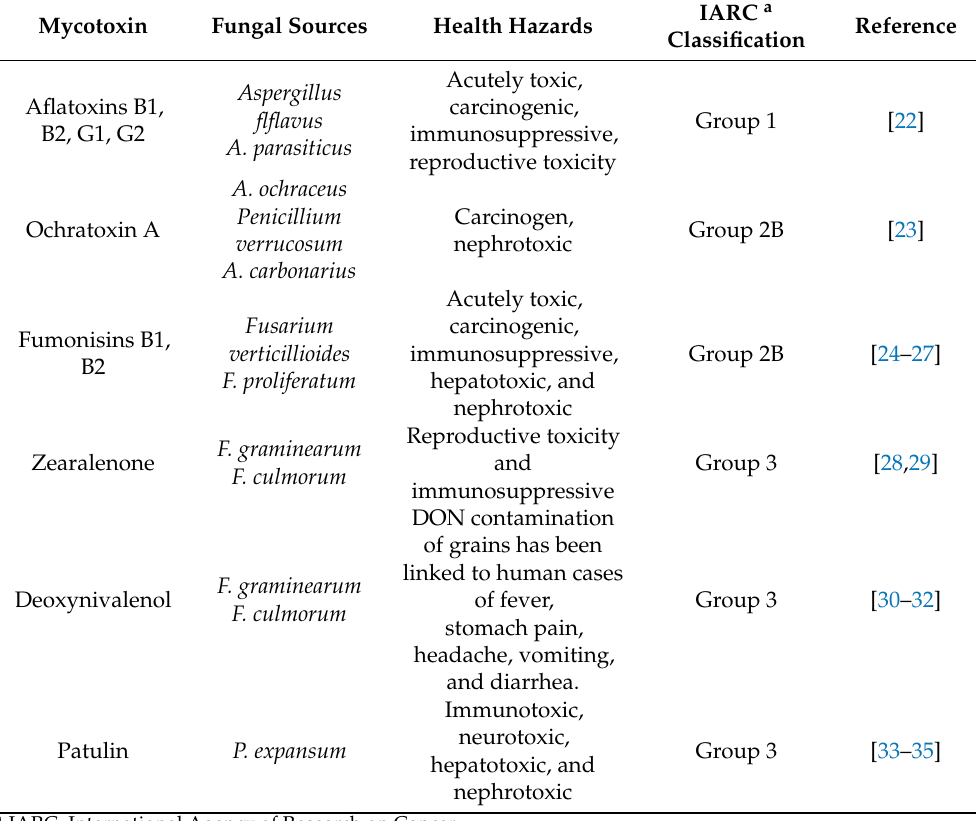
Table 2. The main hazards of six representative categories of mycotoxins to human